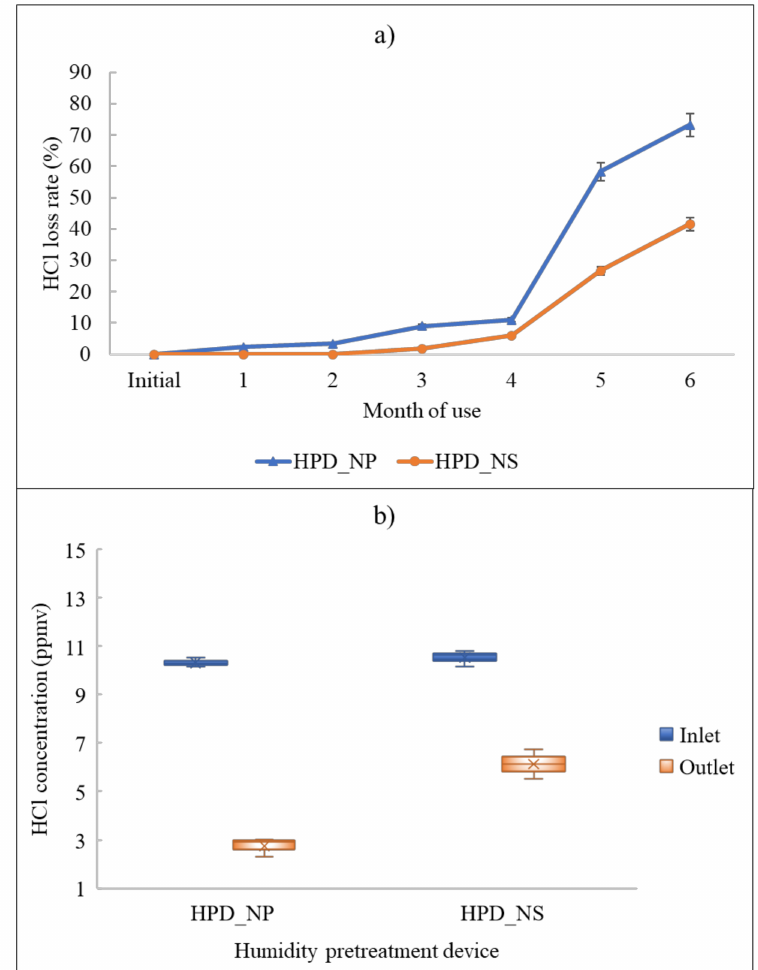
Figure 8. HCl loss due to contaminated membrane after being left in a high operating temperature (80 ◦ C) and high inlet humidity (17%) environment for around six months: ( a ) HCl loss rate with respect to elapsed months, ( b ) inlet and outlet concentrations of HCl after six months of